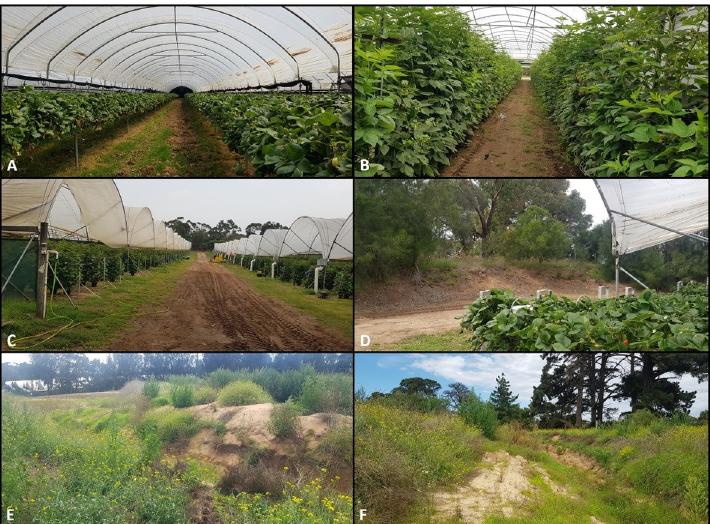
Fig 4. Farm locations. (A) Strawberry polytunnel, (B) raspberry polytunnel, (C) polytunnel edges near the farm road, (D) strawberry polytunnel near remnant habitat, (E-F) weed locations.